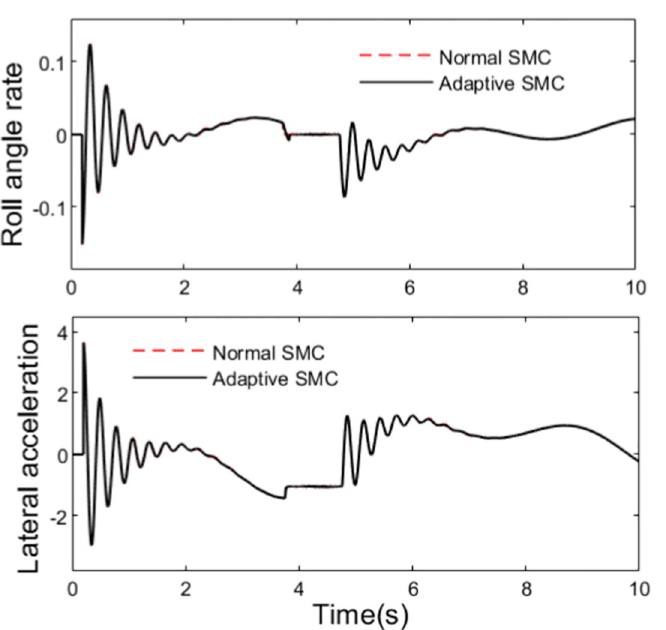
Fig 10. Roll angle rate and lateral acceleration.